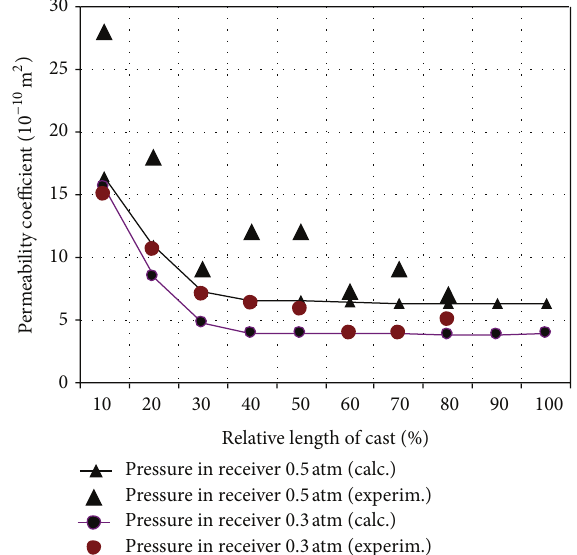
Figure 5: Variation of the permeability coefficient throughout the height of a cast with NaCl fraction of 1.5–2.5